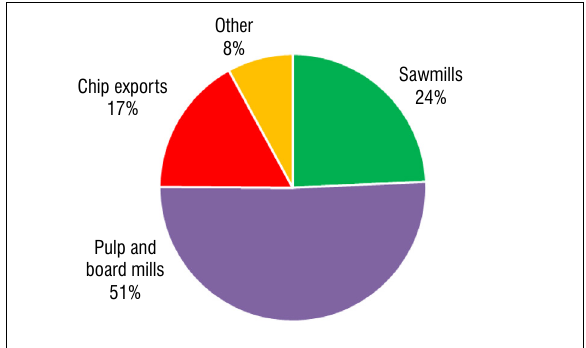
Figure 2: South African industrial roundwood consumption by different sectors. 7